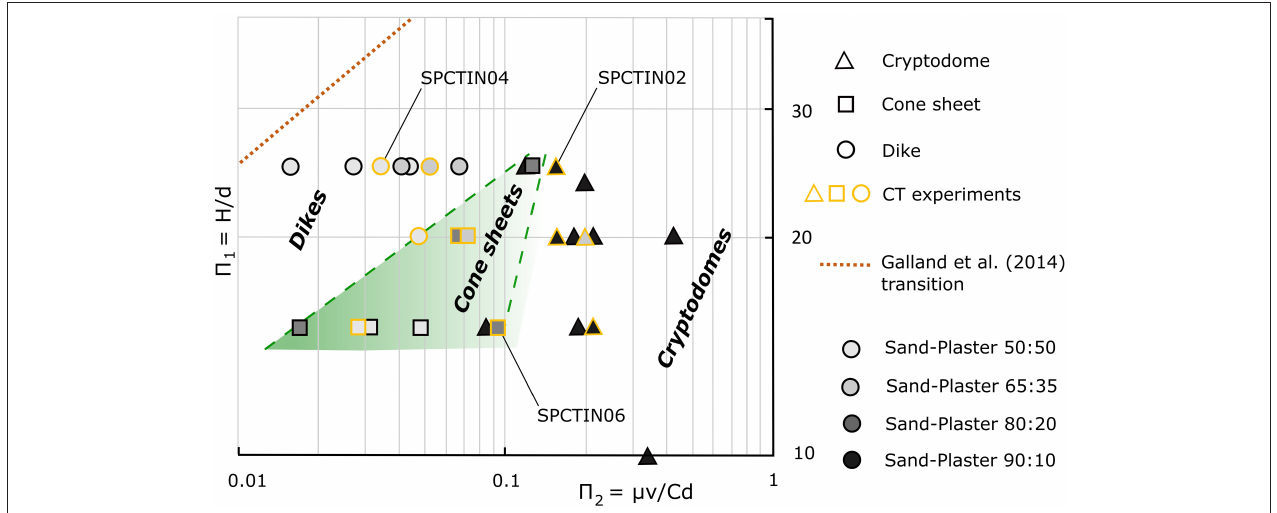
FIGURE 8 | Experimental outcome of intrusion geometries expressed relative to their dimensionless parameter values. Symbol shapes mark intrusion geometries; color-coding marks sand:plaster ratios as an indicator of granular host material strength; yellow symbol edges mark CT experiments. The cone sheet to dike transition is offset to lower Q 2 and higher Q 1 values compared to that experimentally determined by Galland et al. (2014) (red dashed